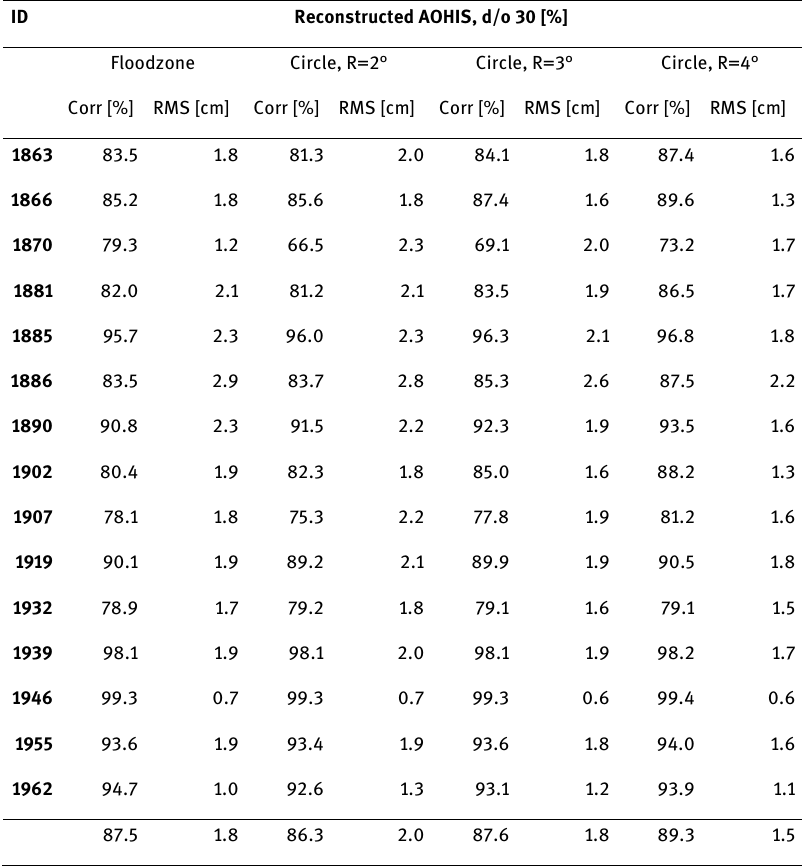
Table 4. Correlation [%] and RMS [cm] of reconstructed AOHIS signal to the original ESA ESM AOHIS for the 15 selected study cases (d/o 30). ID Reconstructed AOHIS, d/o 30 [%] Floodzone Circle, R=2° Circle, R=3° Circle,